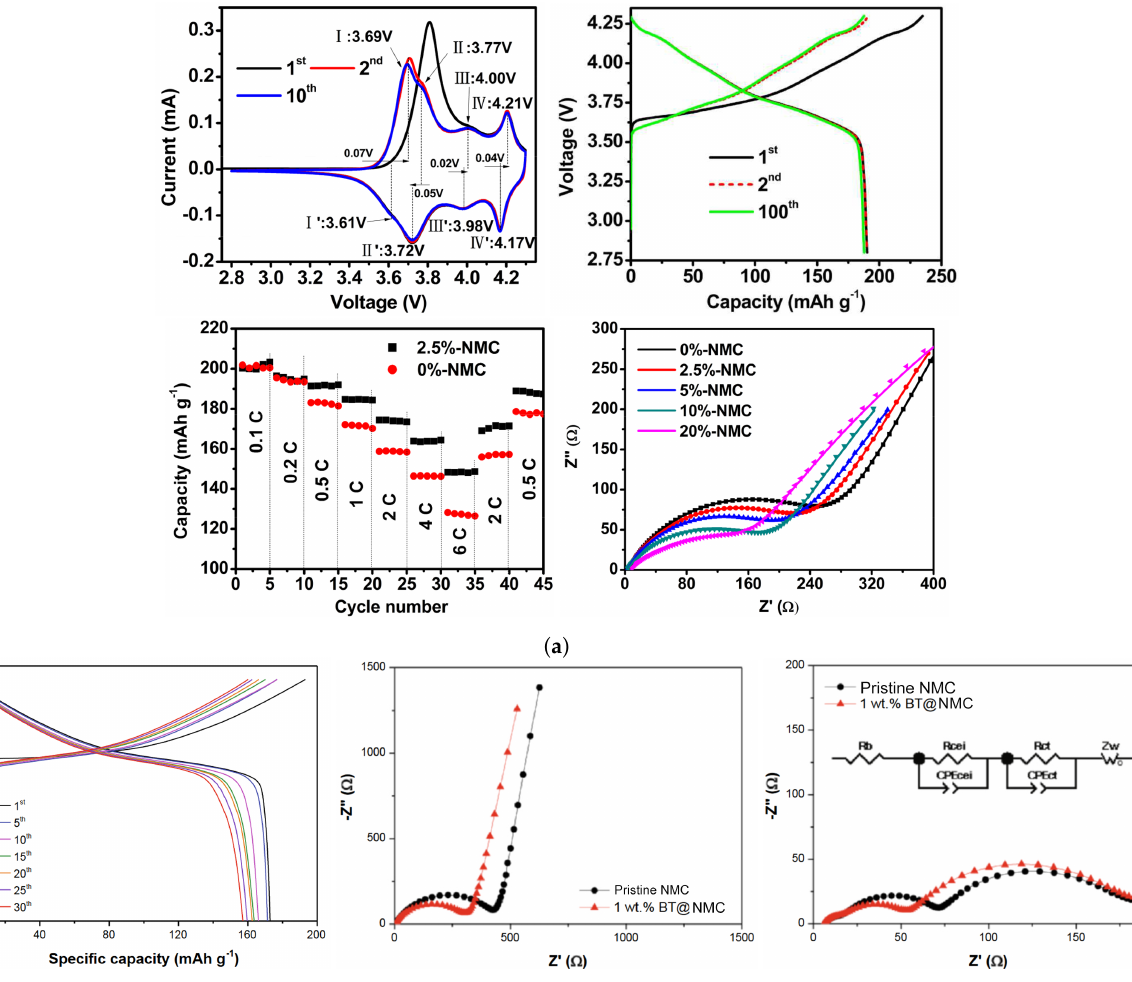
Figure 10. Electrochemical curves for surface coated NMC cathodes. ( a ) Effect of 2.25% carbon coating on NMC: ( Top ) cyclic voltammetry, charge/discharge curves, ( Bottom left ) rate performance. ( Bottom right ) Impedance of NMC cathodes coated with different percentages of carbon. Reproduced with permission [54]. ( b ) Charge/discharge curves for 1 wt% BT@NMC electrodes at 0.1C, Nyquist plots for pristine and 1 wt% BT@NMC after (center) first cycle and (right) after 100 cycles. Reproduced with permission